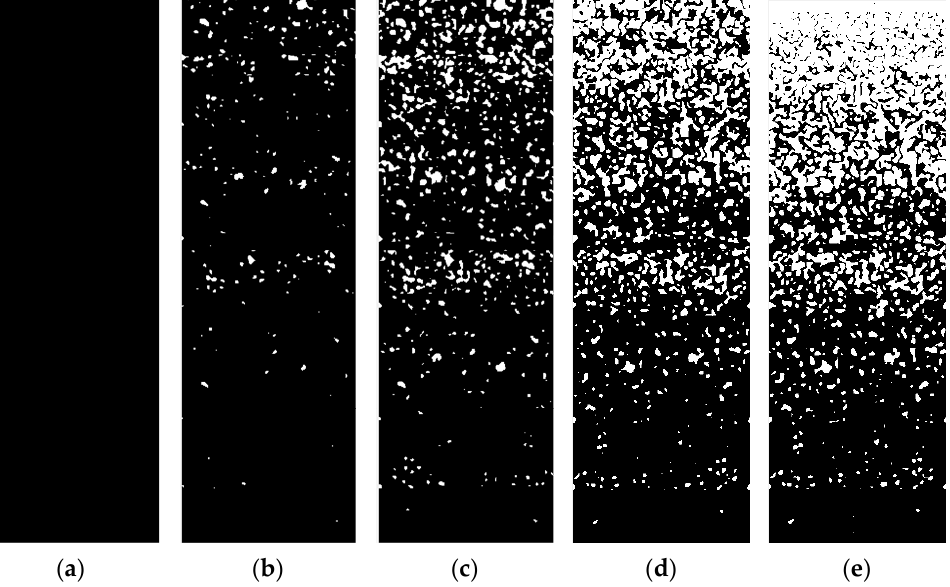
Figure 3. Establishment of the gradient model with ( a ) c 0 = 0; ( b ) c 0 = 0.2; ( c ) c 0 = 0.5; ( d ) c 0 = 0.8; ( e ) c 0 = 1.0 ( m = 1.0).